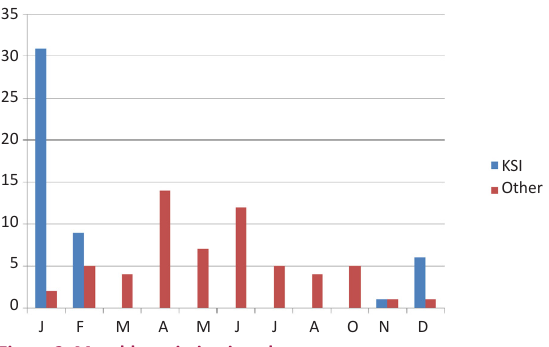
Figure 2. Monthly variation in vulture